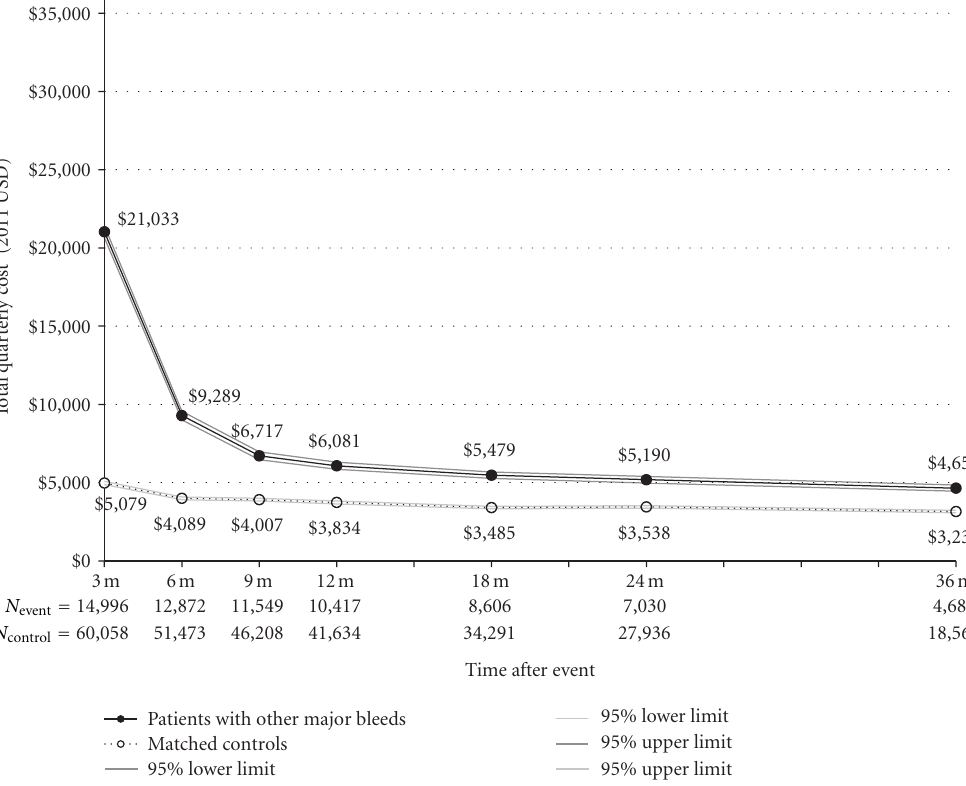
Figure 3: Total Quarterly Cost for Medicare Patients with NVAF with and without Other Major Bleeds. Note: P < 0 . 0001 for di ff erence in costs between patients with events and matched controls at all time points using t -test assuming unequal variances and α = 0 . 05